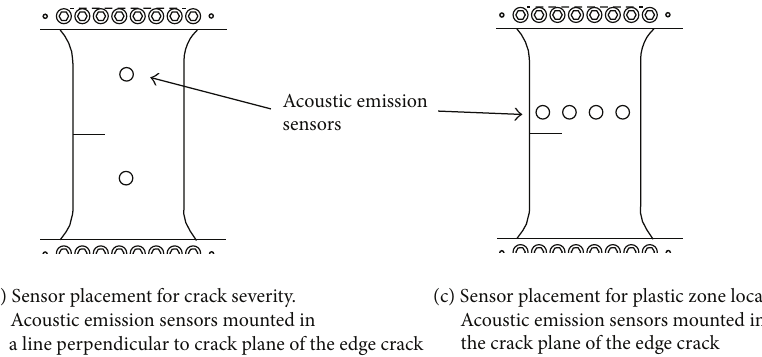
Figure 7: Test panel setup for detecting strain waves from crack propagation. Setup for test panel in pin, clevis setup to be mounted into MTS Sintech 5/G